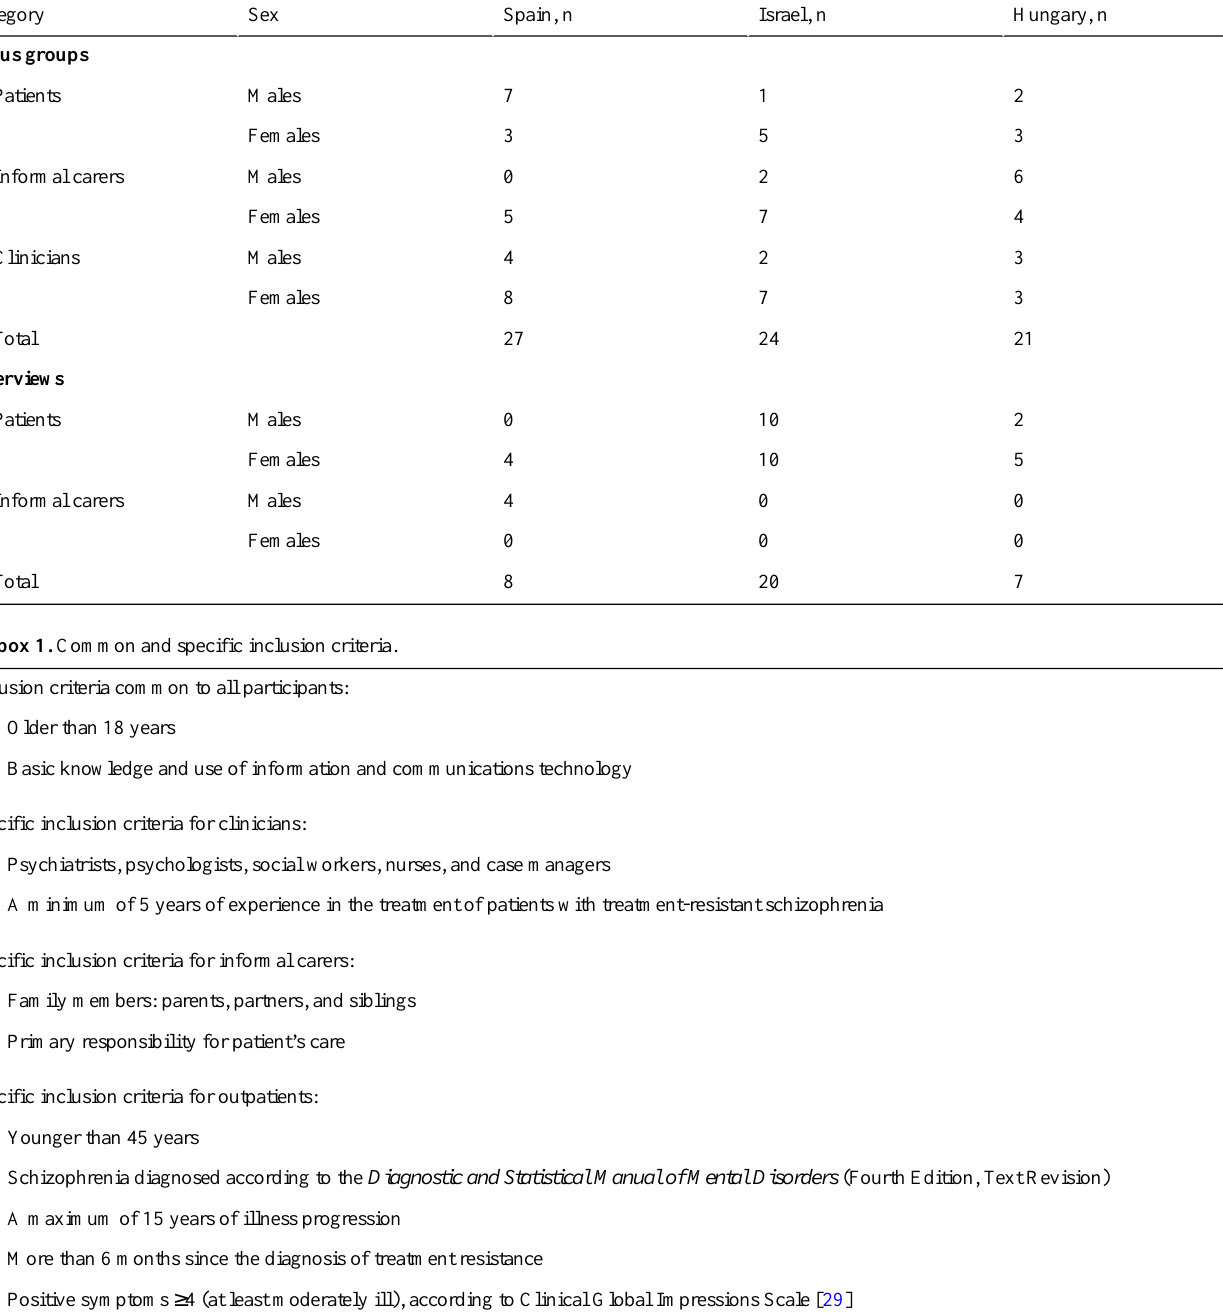
Table 1. Number of people included in focus groups and